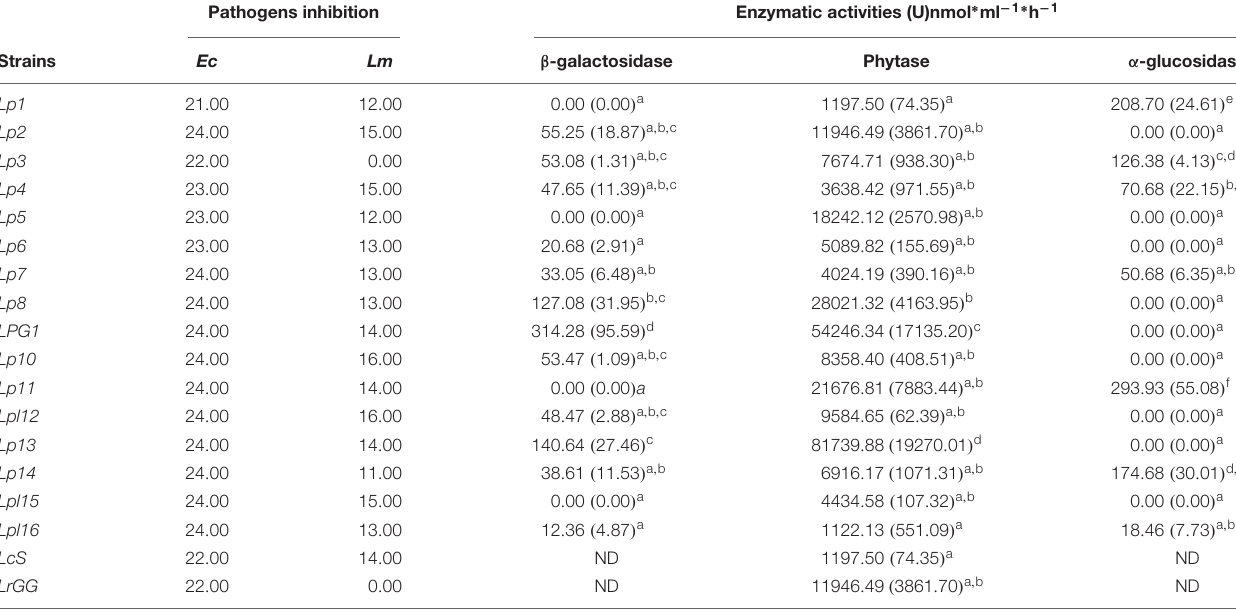
TABLE 4 | Probiotic characteristics for the 16 predominant LAB genotypes obtained in the present study. Pathogens